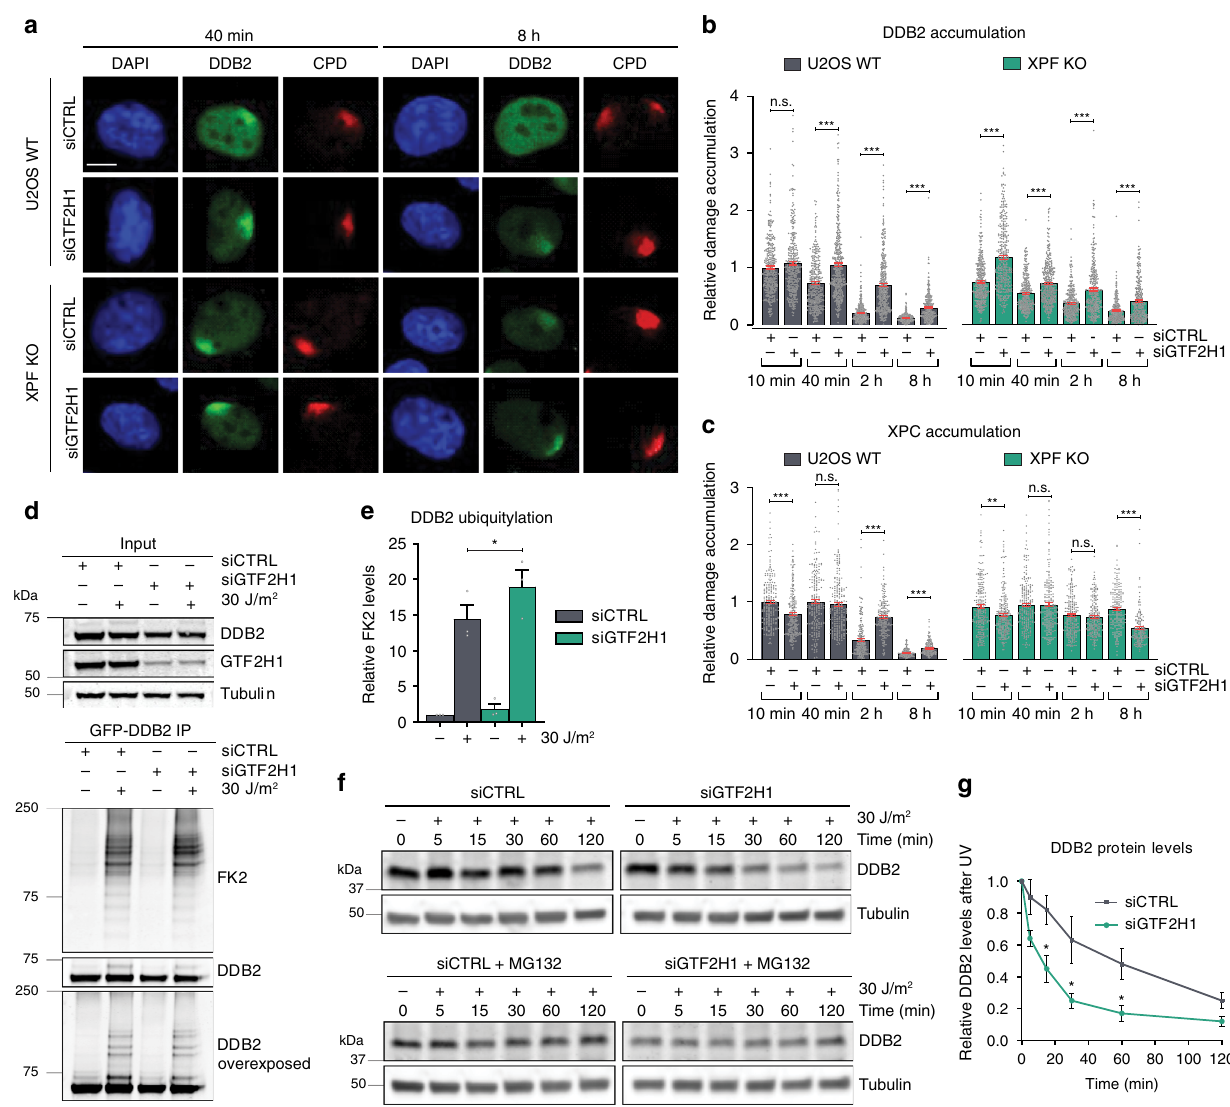
Fig. 3 TFIIH promotes DDB2 dissociation and stable XPC binding. a IF images of endogenous DDB2 LUD accumulation in U2OS WT and XPF KO cells treated with control (CTRL) or GTF2H1 siRNAs, 40 min and 8 h after UV-C irradiation (60 J/m 2 ) Scale bar: 5 µ m. b , c Quanti fi cation of ( b ) DDB2, or ( c ) XPC accumulation at LUD in U2OS WT and XPF KO cells treated with CTRL or GTF2H1 siRNAs, 10 min, 40 min, 2 h and 8 h after damage, as described in ( a ), normalized to the nuclear background and U2OS siCTRL 10 min. Mean and S.E.M. of, respectively, n = 322, 321, 317, 374, 335, 364, 291, 299, 370, 314, 318, 342, 307, 315, 283, 287 cells in ( b ) or 217, 225, 210, 234, 220, 193, 165, 173, 218, 238, 218, 213, 217, 202, 194, 156 cells in ( c ) from two independent experiments. IF images of XPC are shown in Supplementary Fig. 2e. d Immunoblot showing DDB2 ubiquitylation in GFP-DDB2 VH10 cells, before or 15 min after UV-C irradiation (30 J/m 2 ) and treated with CTRL or GTF2H1 siRNAs. Total cell lysates (Input) were analyzed with DDB2, GTF2H1 and Tubulin antibodies. GFP-DDB2 immunoprecipitation (IP) fractions were analyzed using anti-ubiquitin (FK2) and DDB2 antibodies. Control IP is shown in Supplementary Fig. 2f. e Quanti fi cation of ubiquitin levels shown in d , normalized to DDB2 levels and non-irradiated siCTRL samples. Mean and S.E.M. of three independent experiments. f Immunoblot showing UV-induced DDB2 proteolysis in total cell lysates of U2OS cells treated with CTRL or GTF2H1 siRNAs in the absence and presence of MG132 proteasome inhibitor, at the indicated time points after UV irradiation (30 J/m 2 ) and analyzed by DDB2 and tubulin antibody. g Quanti fi cation of DDB2 proteolysis as depicted in ( f ), normalized to tubulin and non-irradiated samples. Mean and S.E.M. of three independent experiments. * P < 0.05, ** P < 0.01, *** P < 0.001, n.s. non-signi fi cant, analyzed by one-way ANOVA in ( b ), ( c ) and by unpaired, two- tailed t -test (adjusted for multiple comparisons) in ( e ), ( g ) (see “ Methods ” ). Source data are provided as a Source Data fi